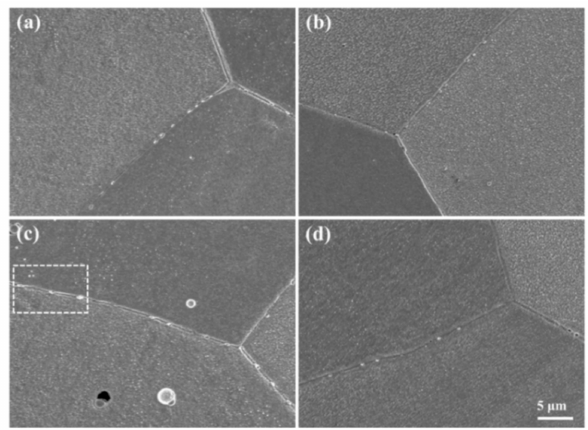
Figure 3. Typical SEM images of ( a ) C00, ( b ) C01, ( c ) C05 and ( d ) C10 specimens, respectively.